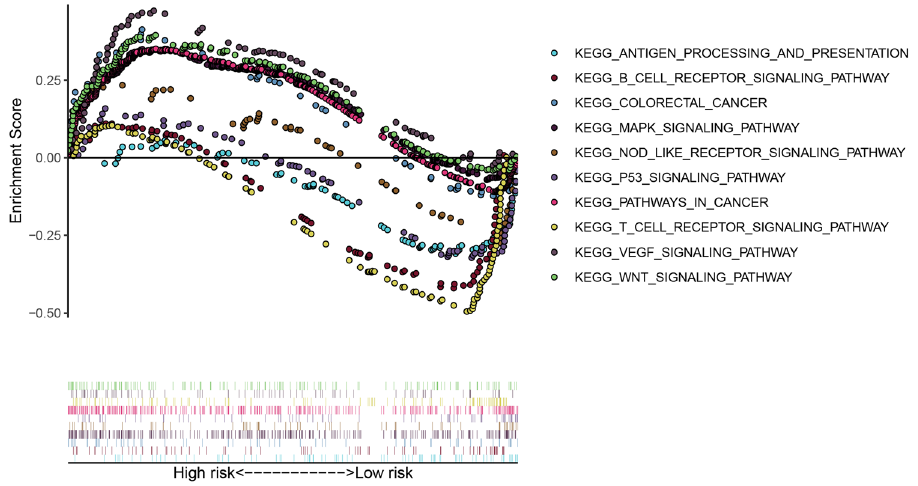
Figure 6. GSEA enrichment analysis between the low- and high-risk